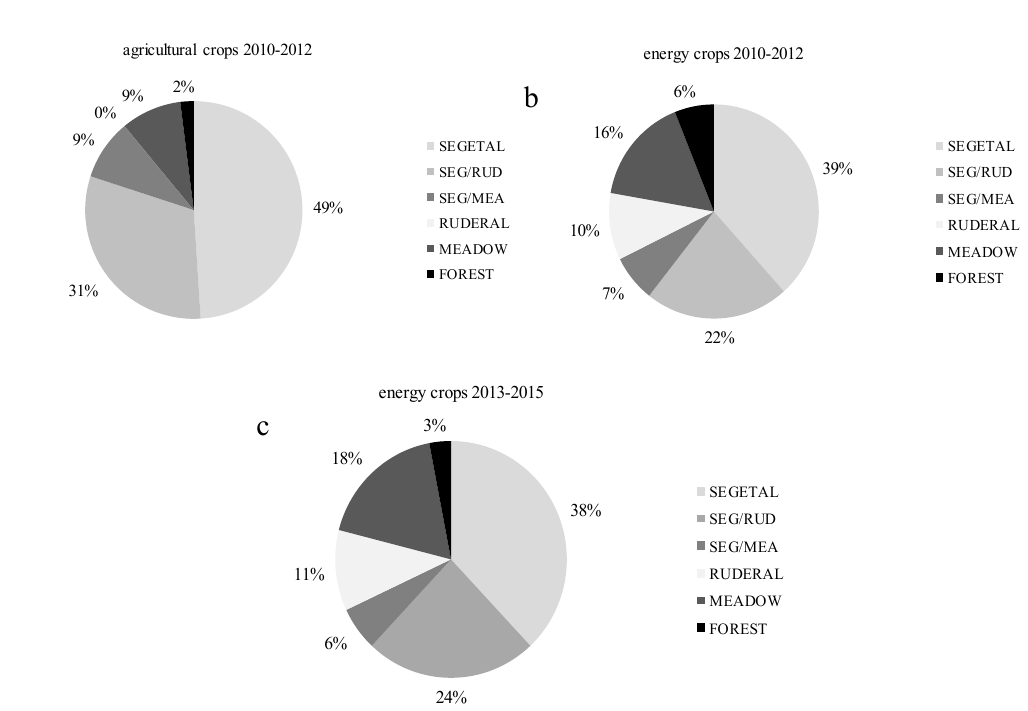
Figure 9. Percentage share of species from different habitats in plant communities accompanying annual agricultural crops and energy crops. ( a ) agricultural crops in the years 2010-2012, ( b ) energy crops in the years 2010-2012, ( c ) energy crops in the years 2013-2015.